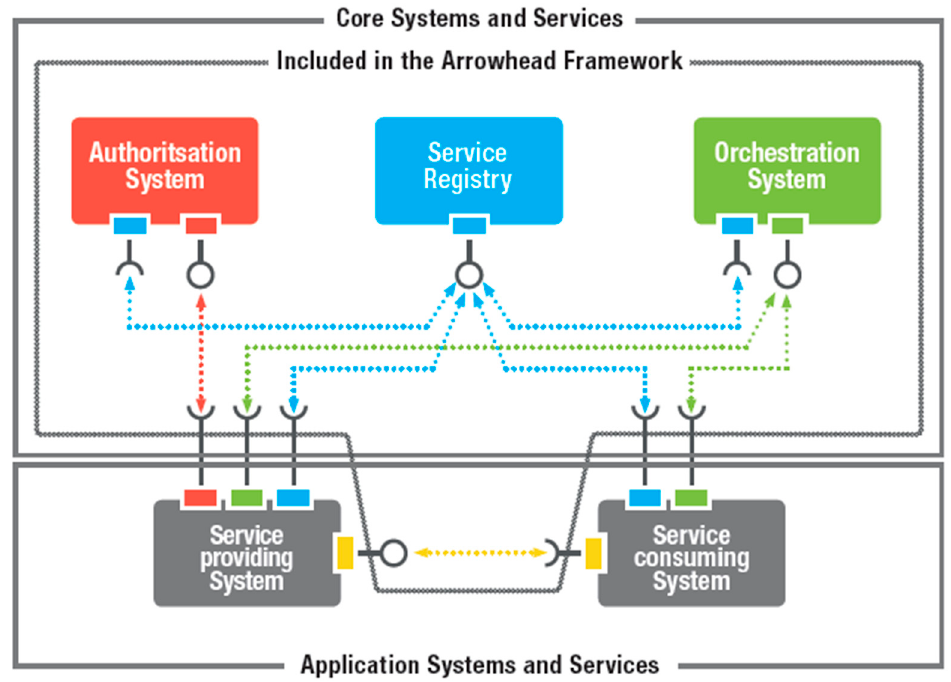
Figure 1. Outline of general architecture of Adage AB’s multi-usable cloud service platform.